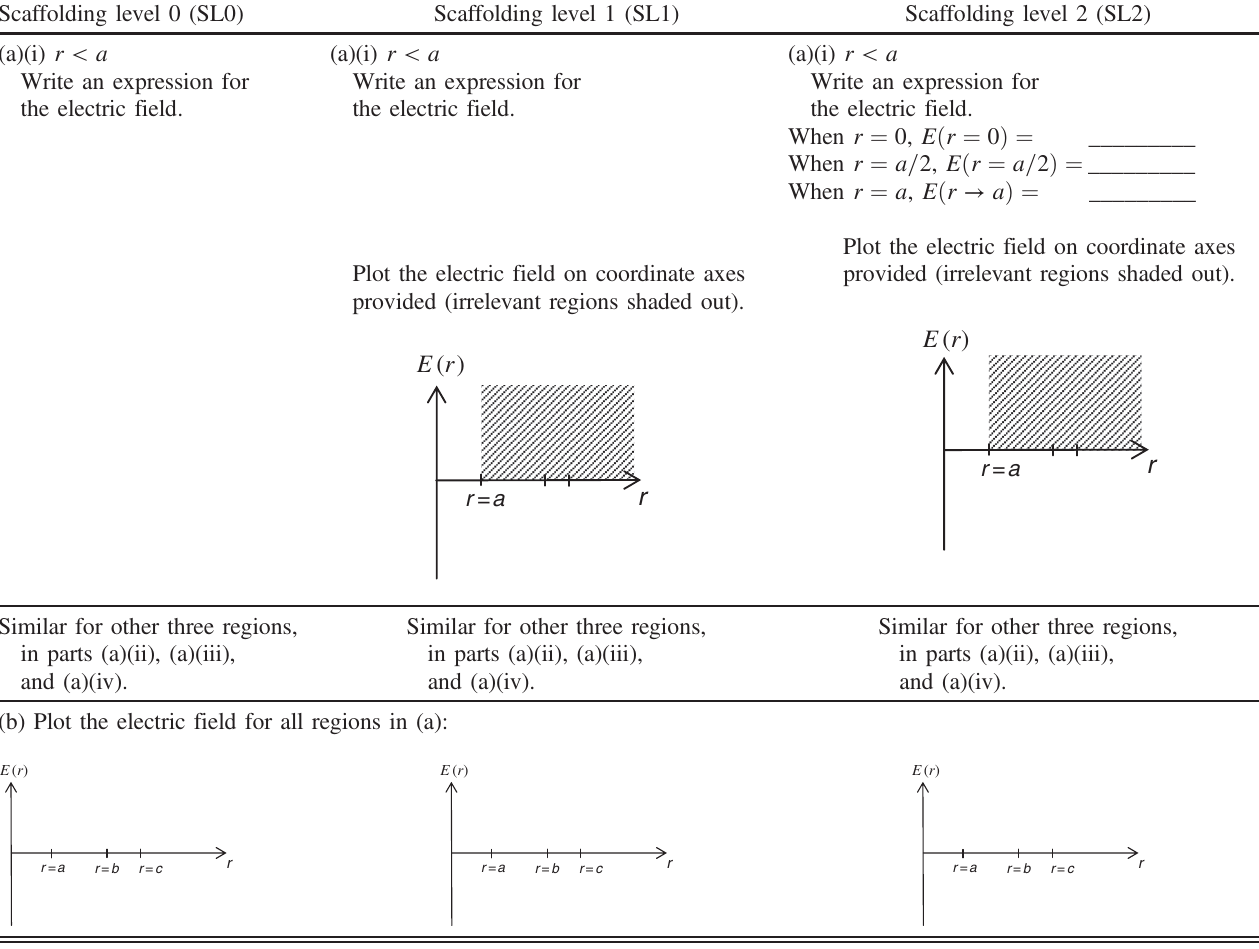
TABLE I. Descriptions of the three scaffolding levels. Scaffolding level 0